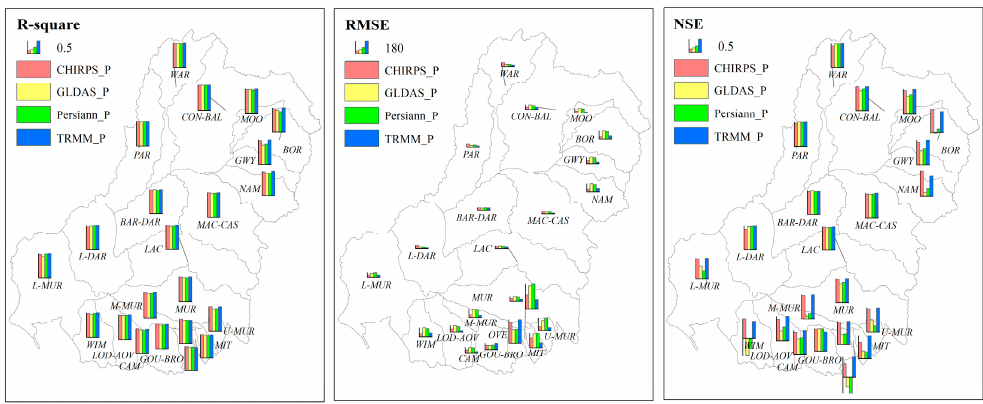
Figure 4. Bar plots show the statistics (coefficient determination ( R 2 ), root mean square errors ( RMSE ) and Nash Sutcliffe Efficiency index ( NSE )). of annual P estimated with CHIRPS P , GLDAS P , Persiann P and TRMM P products within the 22 catchments of the MDB when compared with the annual AWAPP values. The embedded bar plots with numbers at the upper-left corners are the scales for interpreting the bars associated with each catchment.